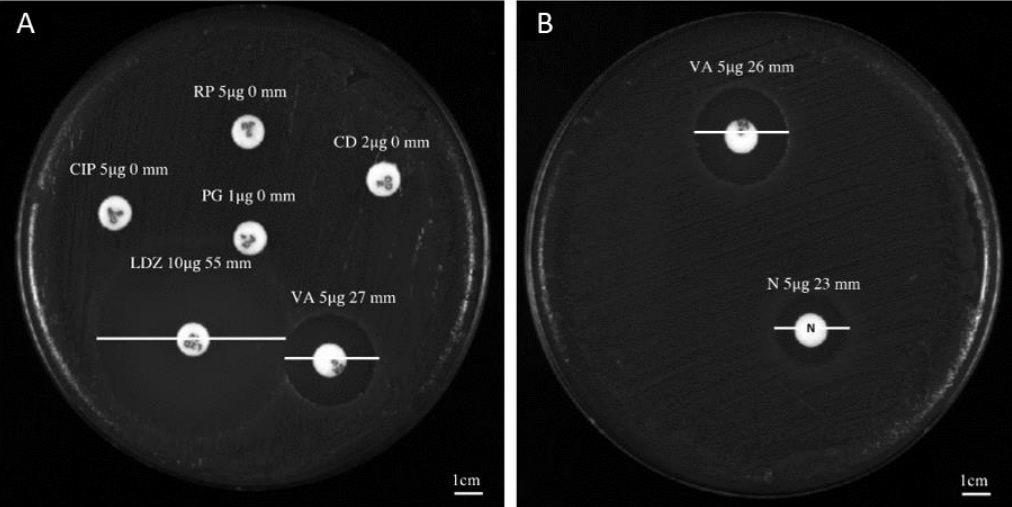
Figure 1. Antibacterial screening study of niclosamide and conventional antibiotics: ( A ) inhibition halo recorded for C. striatum (S 1 ) after treatment with vancomycin (VA, 5 µg), linezolid (LDZ, 10 µg), ciprofloxacin (CIP, 5 µg), rifampicin (RP, 5 µg), benzylpenicillin (PG, 1 µg) and or clindamycin (CD, 2 µg); ( B ) diameter of the inhibition area exhibited by C. striatum (S 1 ) after exposure with ni- closamide (N, 5 µg).